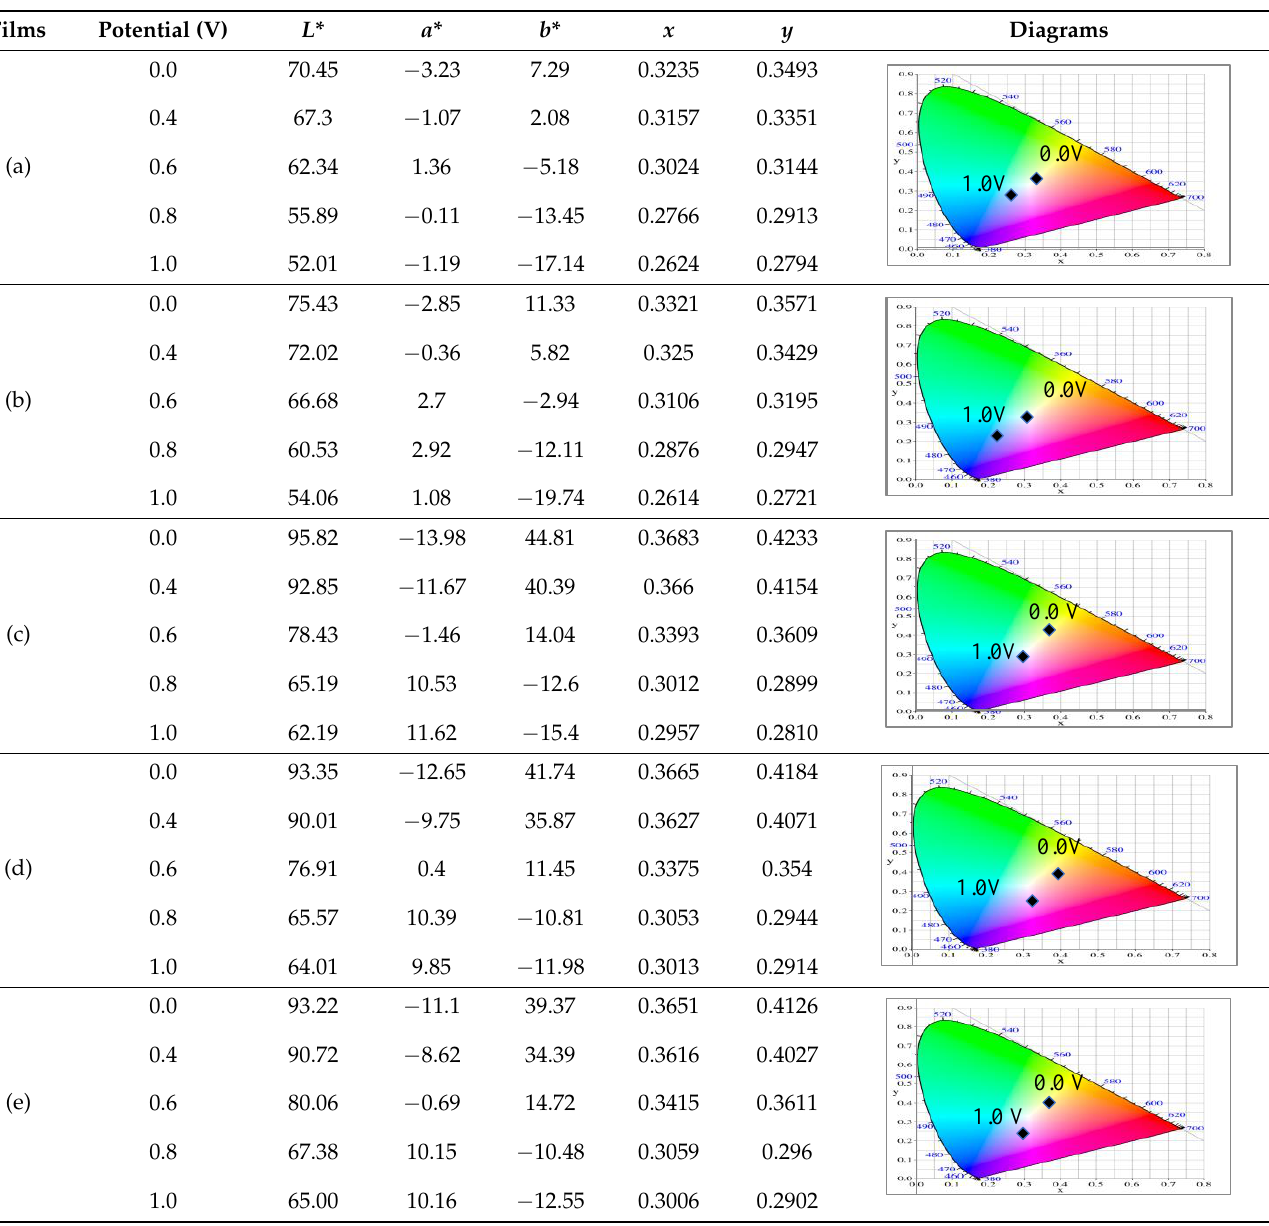
Table 2. Colorimetric values ( L *, a *, and b *), CIE chromaticity values ( x , y ), and CIE diagrams of (a) PDTC, (b) P(DTC- co -BTP),